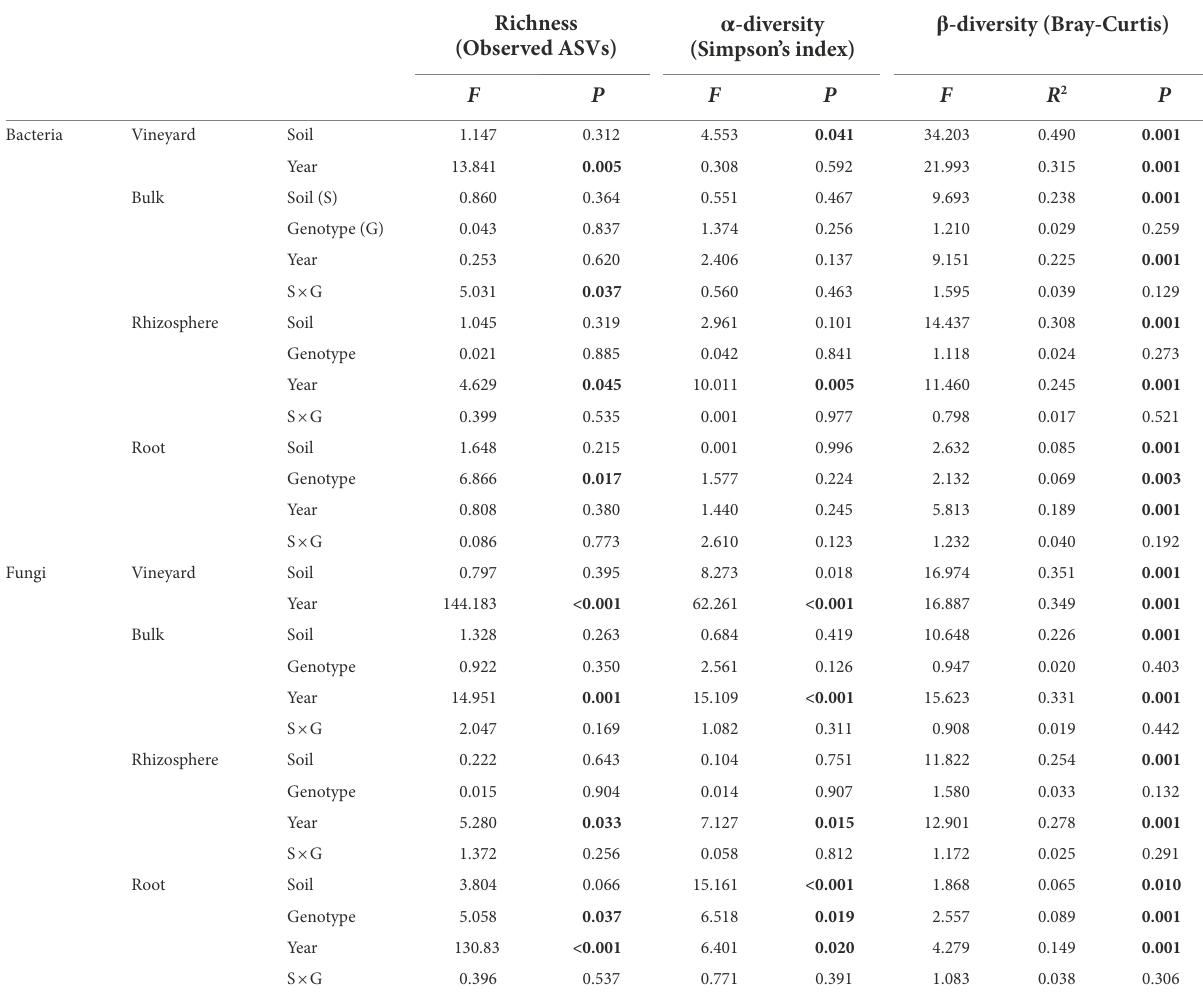
TABLE 1 Effect of soil type (S, AS), rootstock genotype (RGM, 1103P), and year of the experiment (2019, 2020) on richness, α -diversity, and β -diversity of bacterial and fungal communities in the bulk, rhizosphere, and roots compartments in the greenhouse experiments. Richness (Observed ASVs)